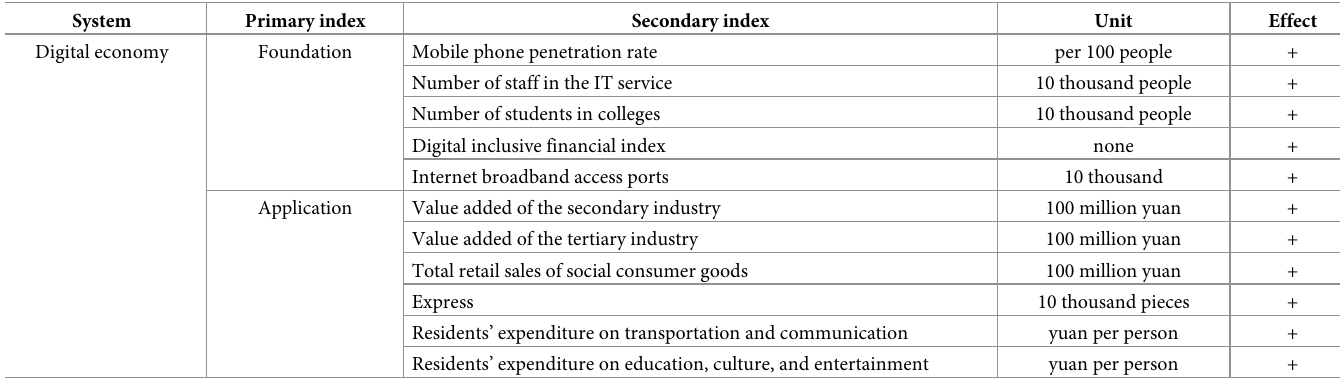
Table 2. Measurement system for the digital